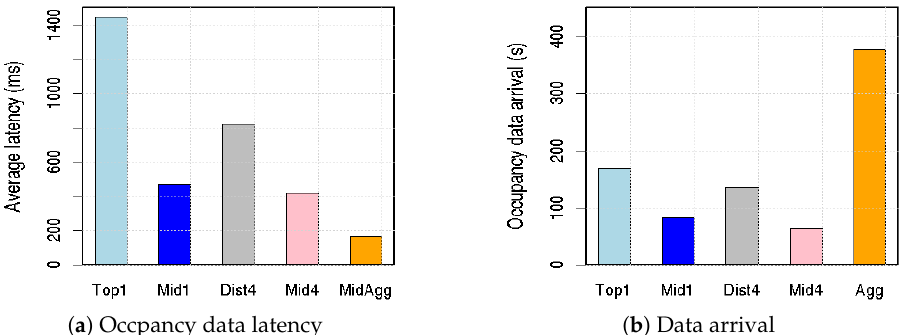
Figure 8. Metrics for the communication models. ( a ) Latency for occupancy data packets. ( b ) Arrival of occupancy data from all nodes.